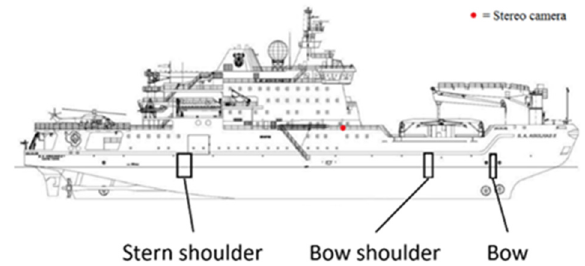
Figure 2. Location of strain gauges on the S.A. Agulhas II. (The figure was determined based on Suominen & Kujala [40]).